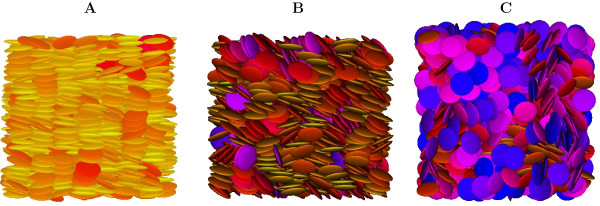
HT-T, MC Snapshots. Snapshots from MC simulations of system Q1 at T* = 0.6 (A), T* = 0.8 (B), T* = 1.4 (C). The orientation of the molecules, with respect to the director, is rendered using a color coding ranging from yellow (parallel) to blue (perpendicular).